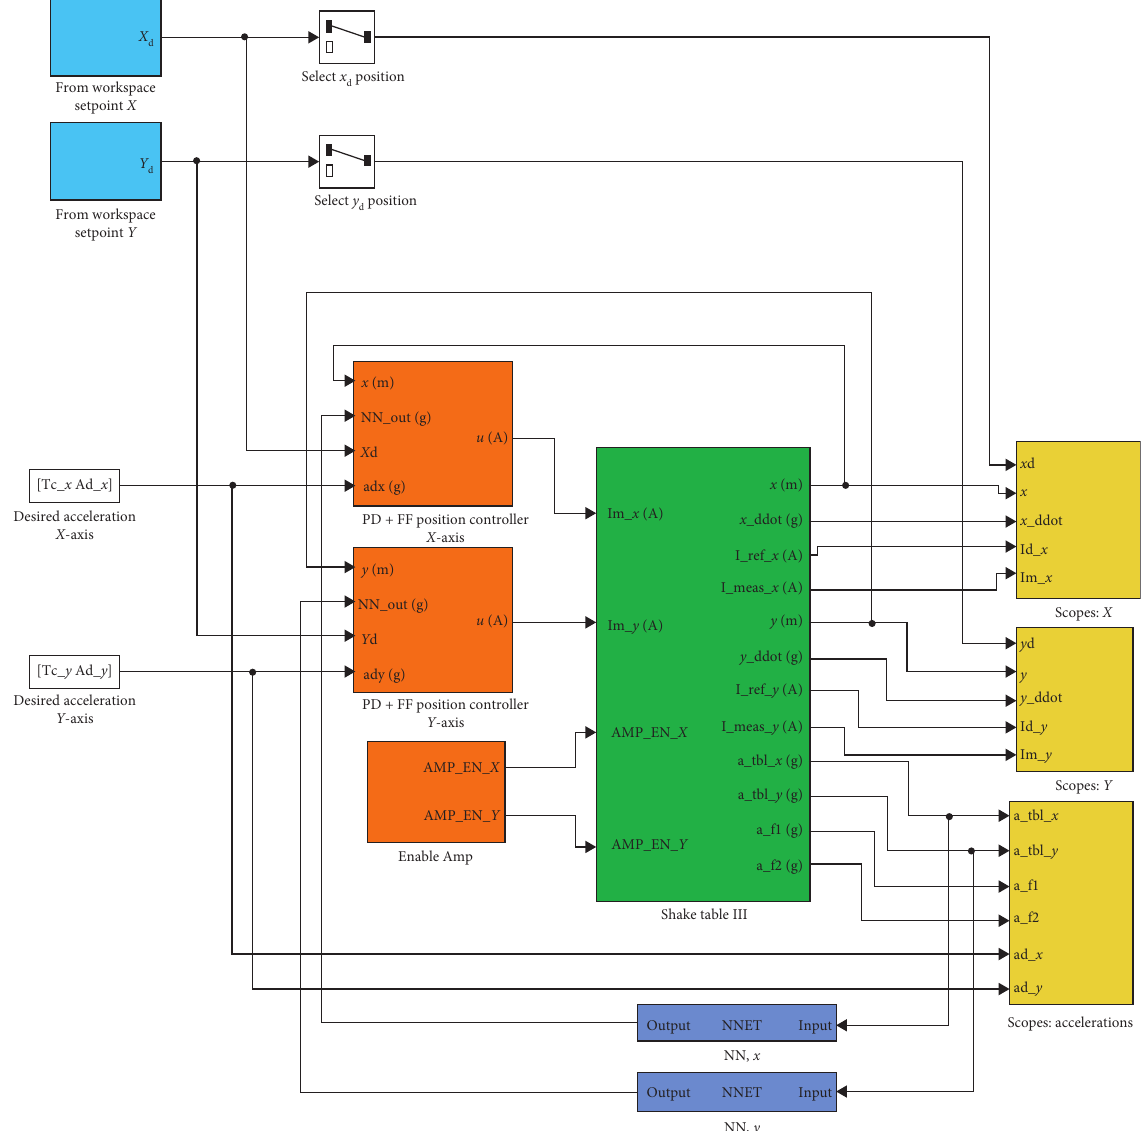
Figure 8: Simulink diagram of QUANSER STIII with the online NN-PDFF controller. Table 5: Parameters of the QUANSER STIII Simulink diagram. Units Desired table position along X - and Y -axis m Measured table position along X - and Y -axis m Measured table acceleration along X - and Y -axis g Computed table acceleration from measured position along X- and Y -axis g Measured acceleration of the specimen floor 1 and 2 g Scaled command time array s Scaled table position command array cm Current reference along X- and Y -axis A Measured current on linear motor along X- and Y -axis A Current amplifier along X- and Y -axis